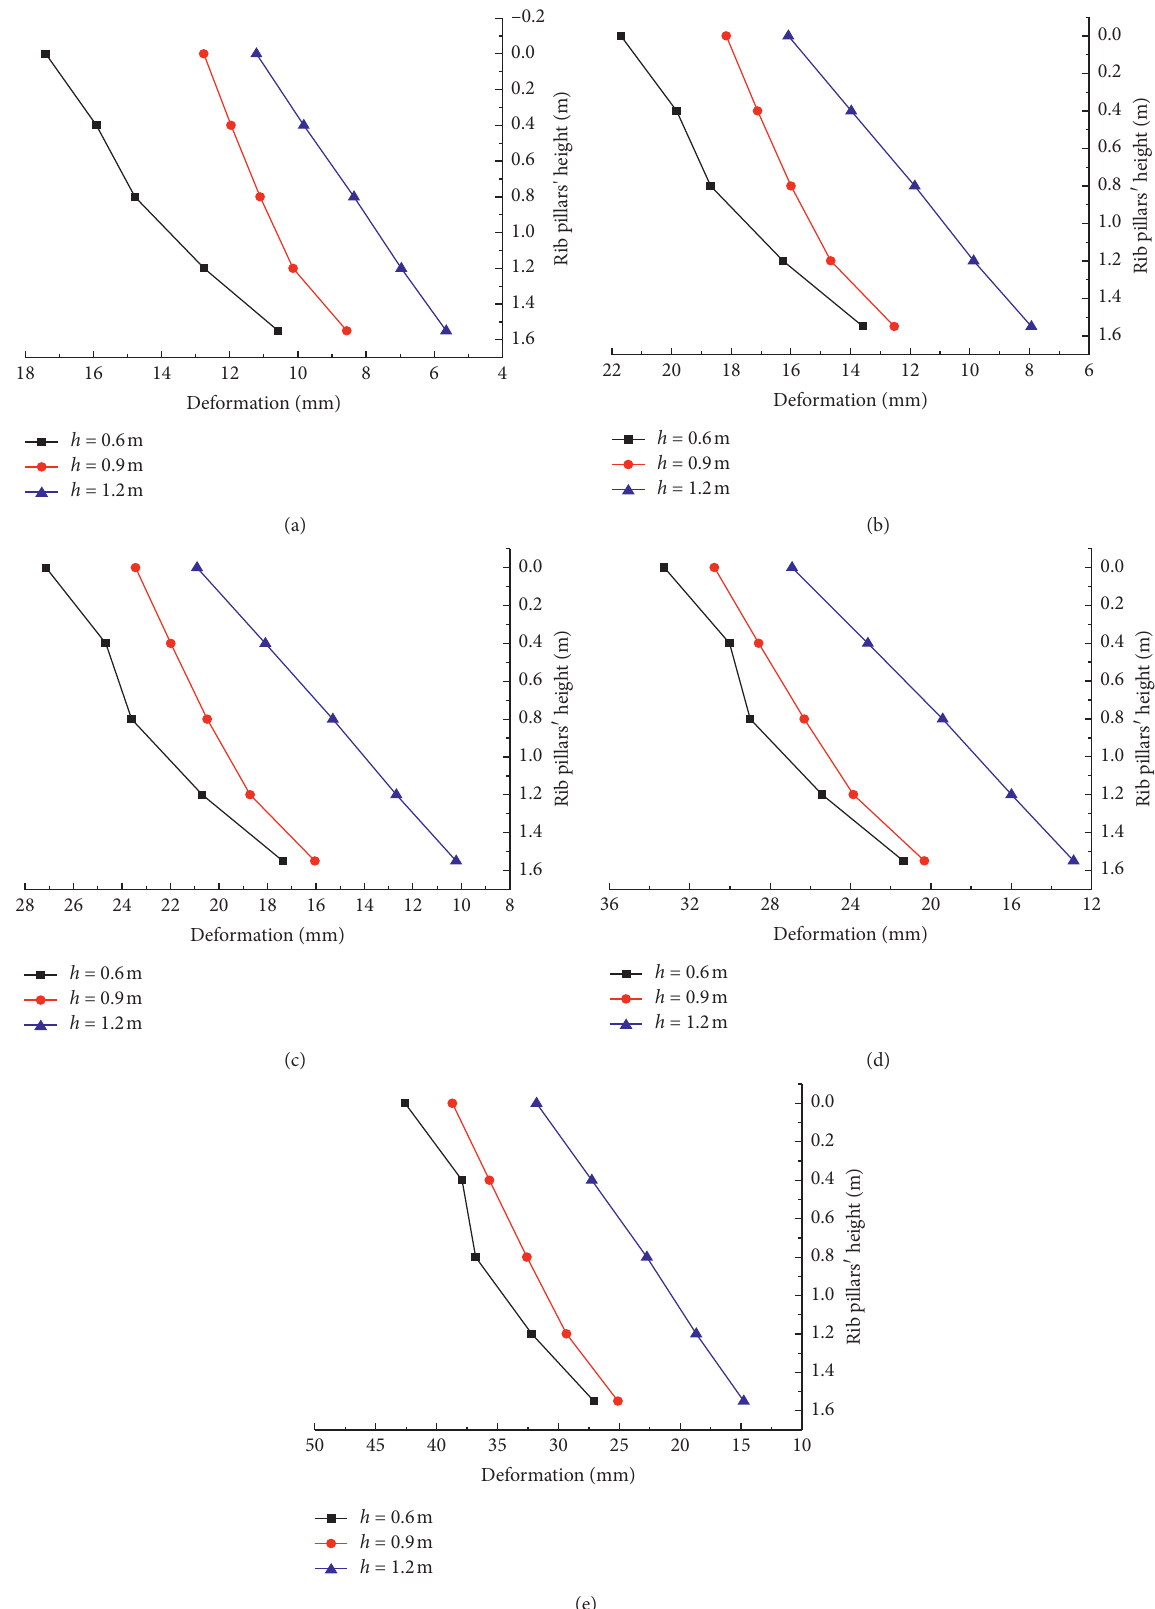
Figure 15: The variation curve of the deformation of rib pillars with the wall body when B � 1.0m at the external load: (a) B � 1.0m ( p � 10 kPa), (b) B � 1.0m ( p � 20kPa), (c) B � 1.0m ( p � 30kPa), (d) B � 1.0m ( p � 40kPa), and (e) B � 1.0m ( p �